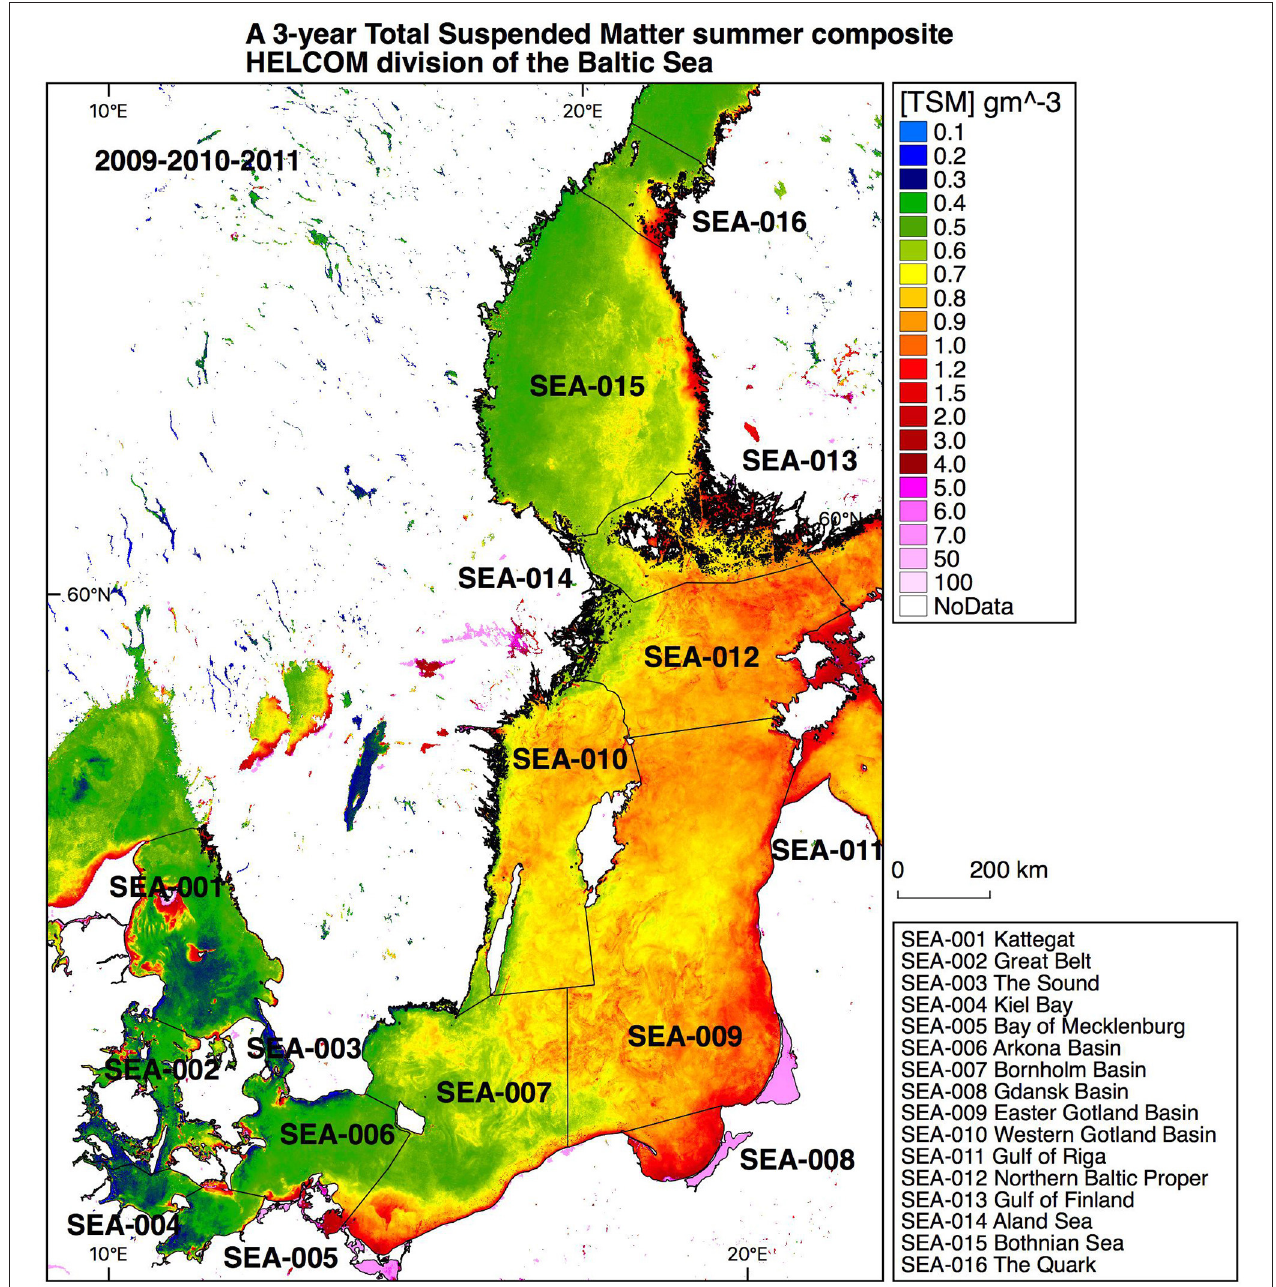
FIGURE 3 | A 3-year TSM summer composite superimposed by HELCOM sub-basins (http://metadata.helcom.fi/geonetwork/srv/eng/catalog.search#/metadata/ d4b6296c-fd19-462c-94d2-4c81b9313d77).